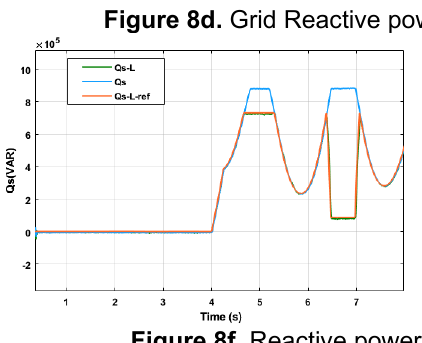
Figure 8e. Active power Figure 8f. Reactive